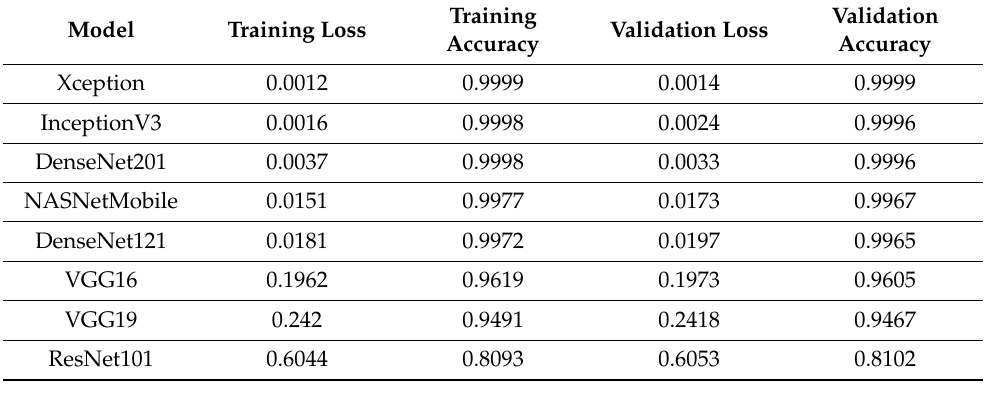
Table 2. Model Performance comparison for transfer learning from ULTT datasets.